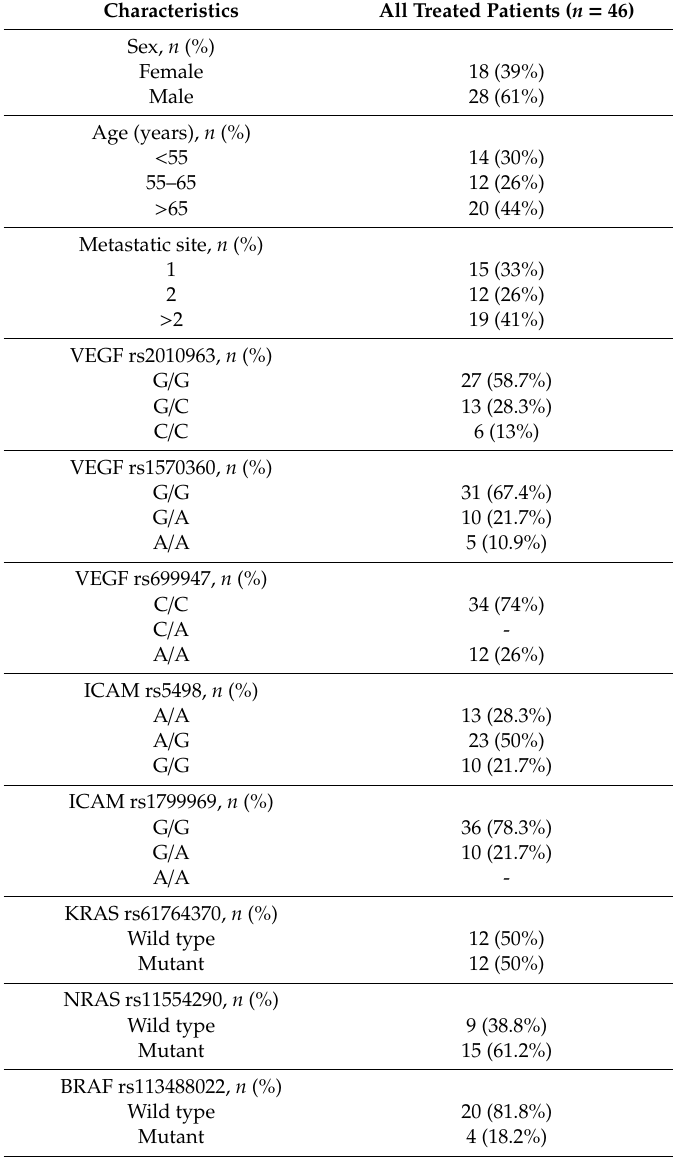
Table 1. Baseline patient characteristics and genotype